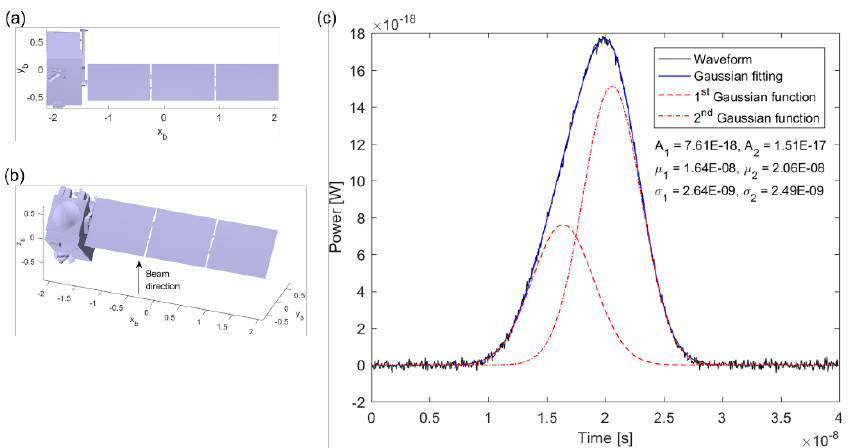
Figure 6. The ( a ) reflected surface, ( b ) orientation of defunct satellite, and ( c ) the echo waveform and 2 Gaussian functions obtained from the Gaussian decomposition for 45° rotation about the x-axis w.r.t. Figure 2a.